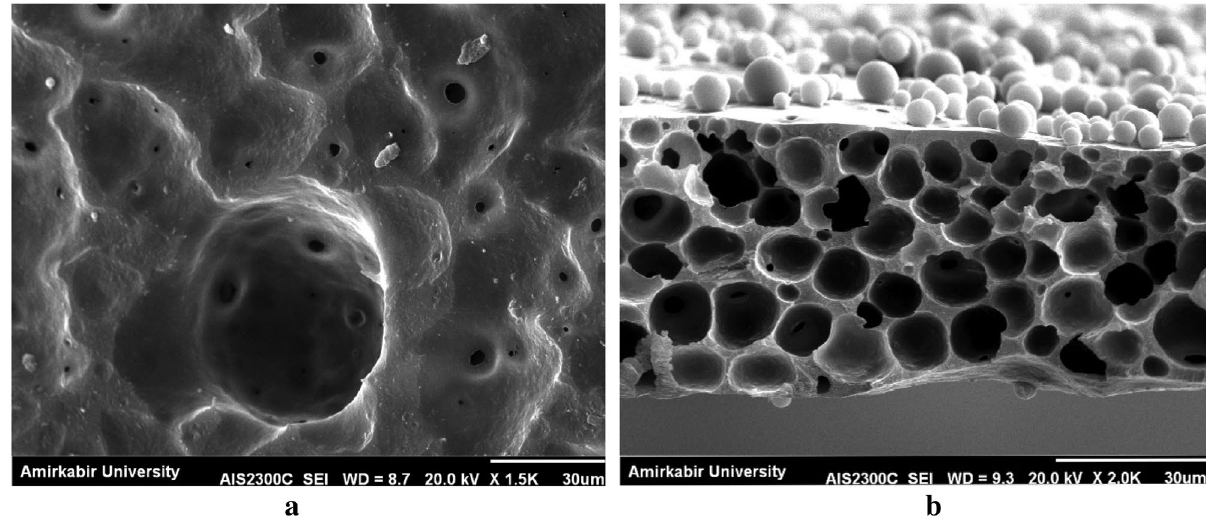
Figure 1. ( a ) the bottom and ( b ) cross section SEM images of SAN 25 (containing 25% acrylonitrile and 75% styrene) using DMF as solvent, polymer concentration = 8%; Temperature = 0 °C, BWB time = 300 s, Casting knife gap = 250